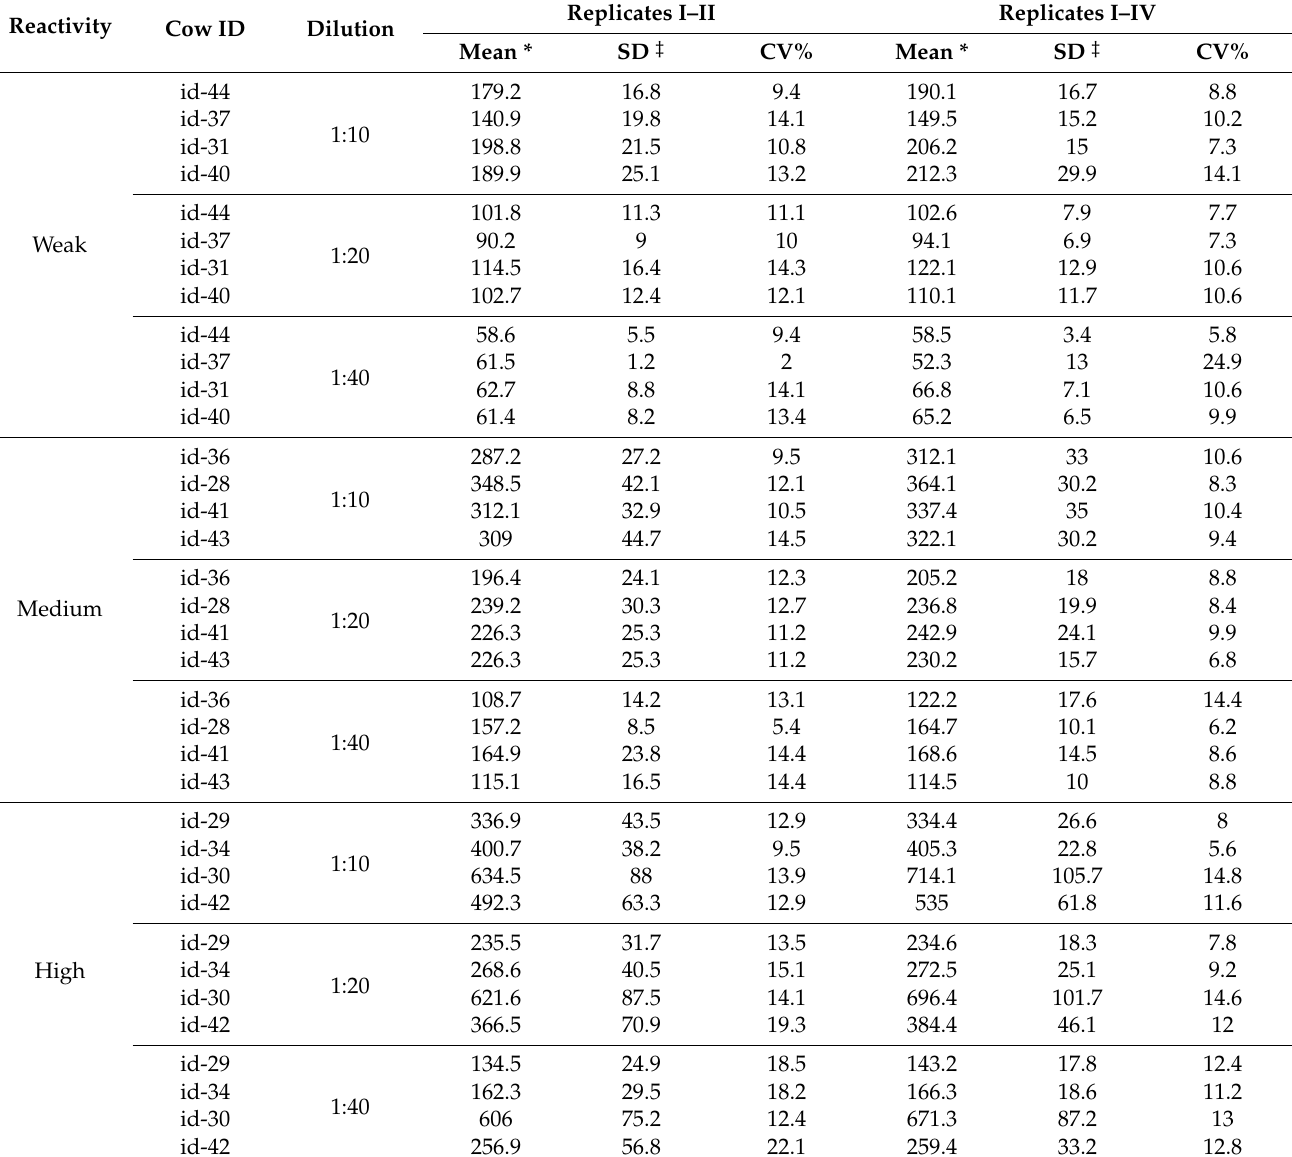
Table 5. Evaluation of within-run repeatability and between-run repeatability on the positive refer- ence samples, showing mean value, standard deviation, and coefficient of variation of S/P (sample- to-positive control ratio) among replicates (I–II and I–IV respectively) for each positive reference